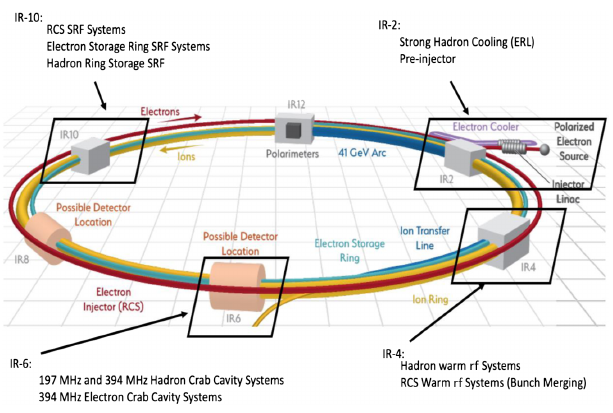
FIG. 1. rf systems in